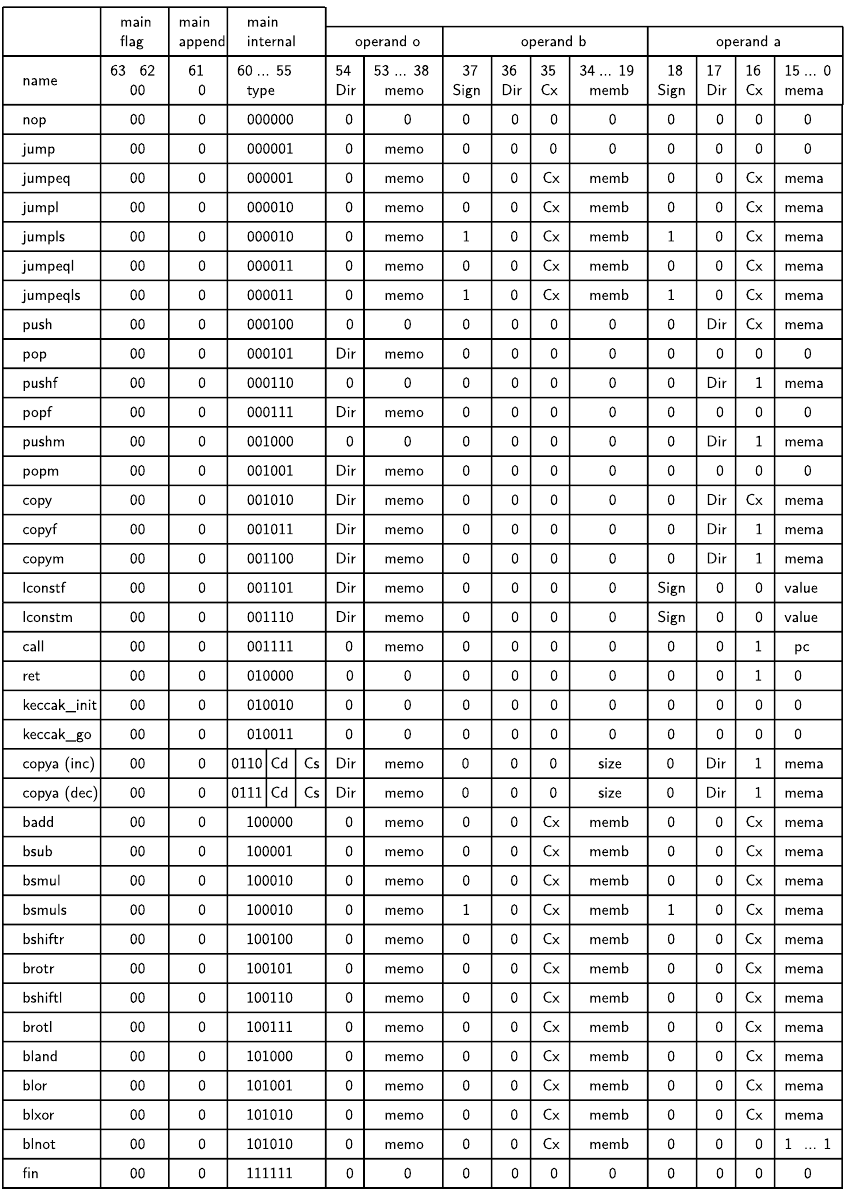
Figure 17: The main instructions for the SIKE